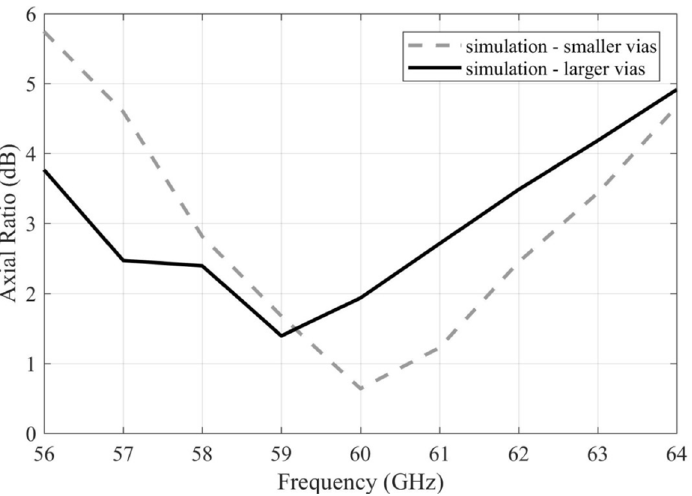
Figure 7. Frequency responses of the AR magnitude for the simulated arrays with smaller and larger vias.